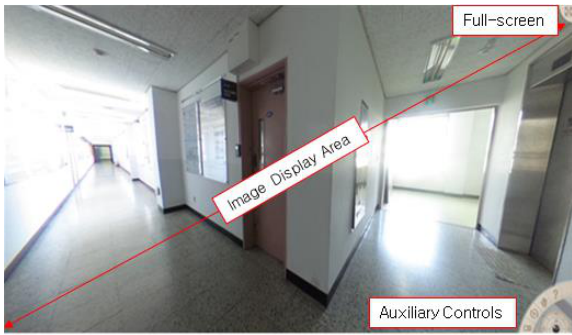
Figure 13. Basic interface of the demo program The user can pan, zoom, and scroll around a singe point, the position being the shooting point of the omnidirectional image, both using the mouse and the auxilliary controls. A full-screen display option is also available.